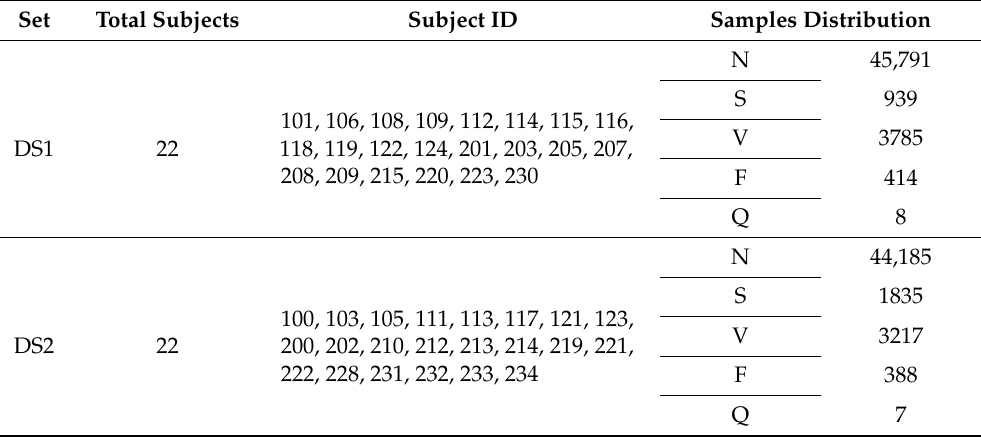
Table 3. Distribution of training and test sets under the inter-patient